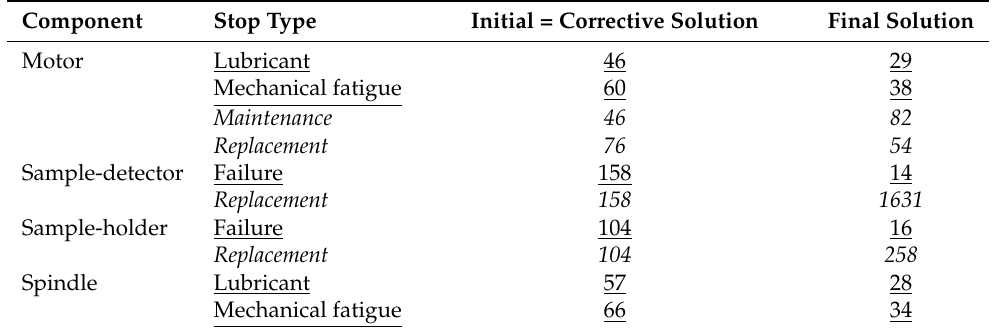
Table 13. Numbers of stop instances yielded from training the model for the friction welding machine (HWH) within the simulation interval (292 years). Underlined and italic contents correspond to failures and strategies, respectively.